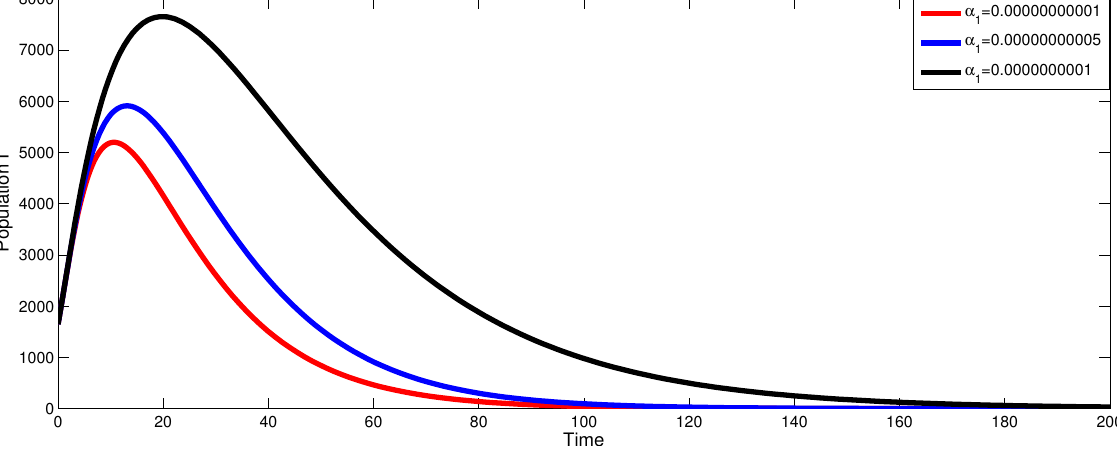
Fig. 6. Time series of infected population with α 1 = α 2 using data from Table 1, 2 starting from 1 st April to 29 th